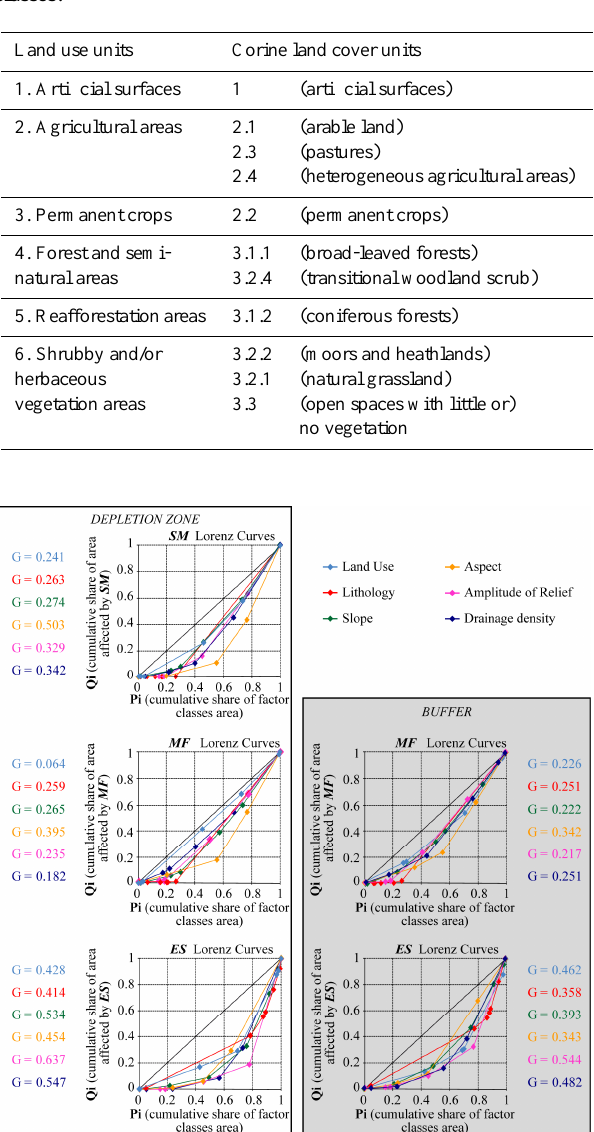
Table 1. Classification of Corine Land Cover units in land use classes.